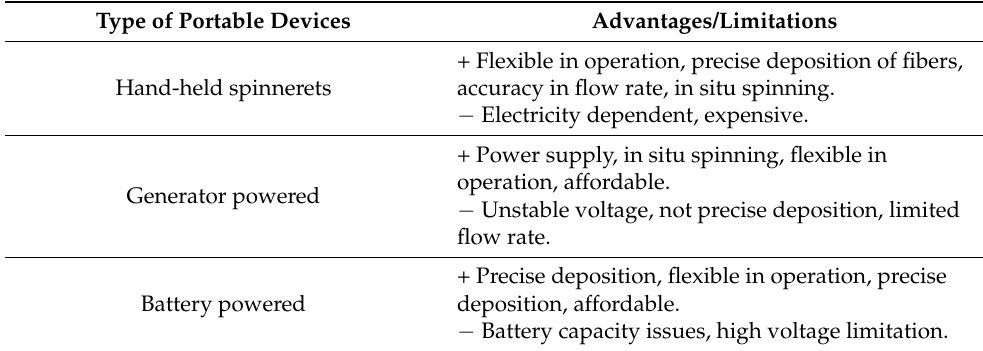
Table 5. Sources of power for portable electrospinning devices. Type of Portable Devices